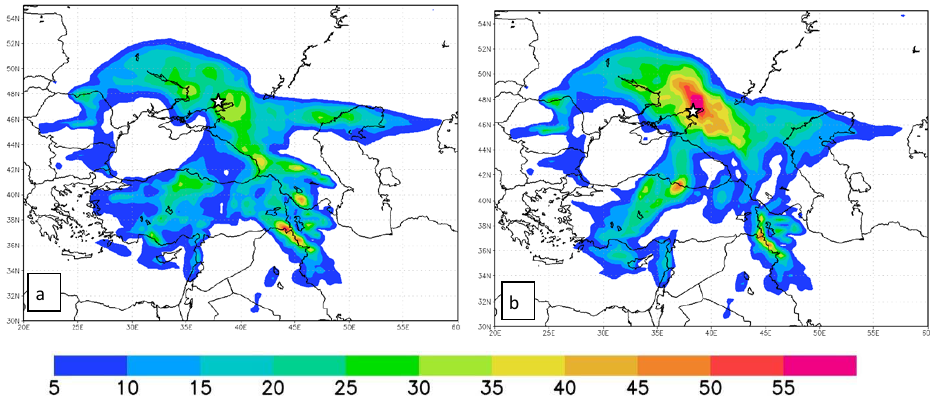
Fig. 3 24-h forecasts of precipitation (mm) on14 March 2009 for (a) CTL and (b) EXP. Fig. 3. 24-h forecasts of precipitation (mm) on 14 March 2009 for (a) CTL and (b) EXP.